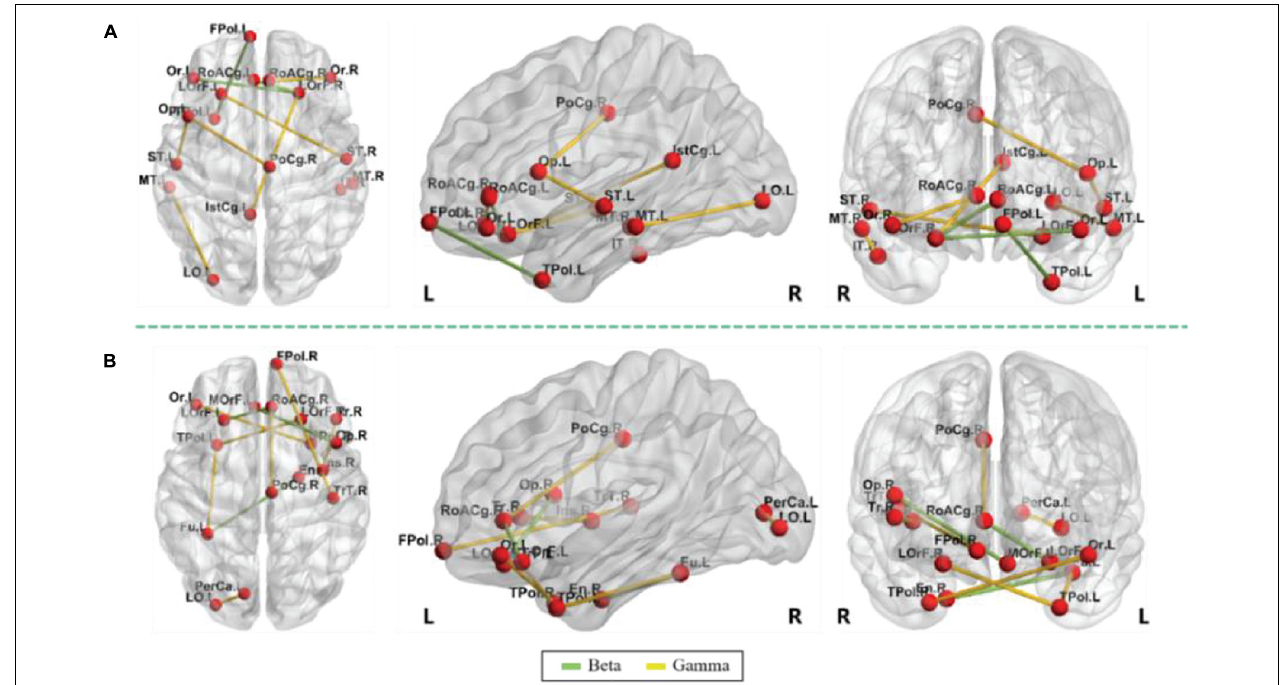
FIGURE 3 | Discriminative top 10 features, panel (A) is self-imagination and panel (B) is virtual reality (VR)